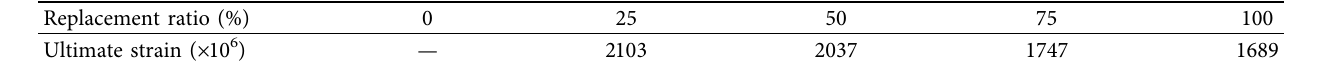
Table 4: Ultimate strain of recycled lightweight aggregate concrete.